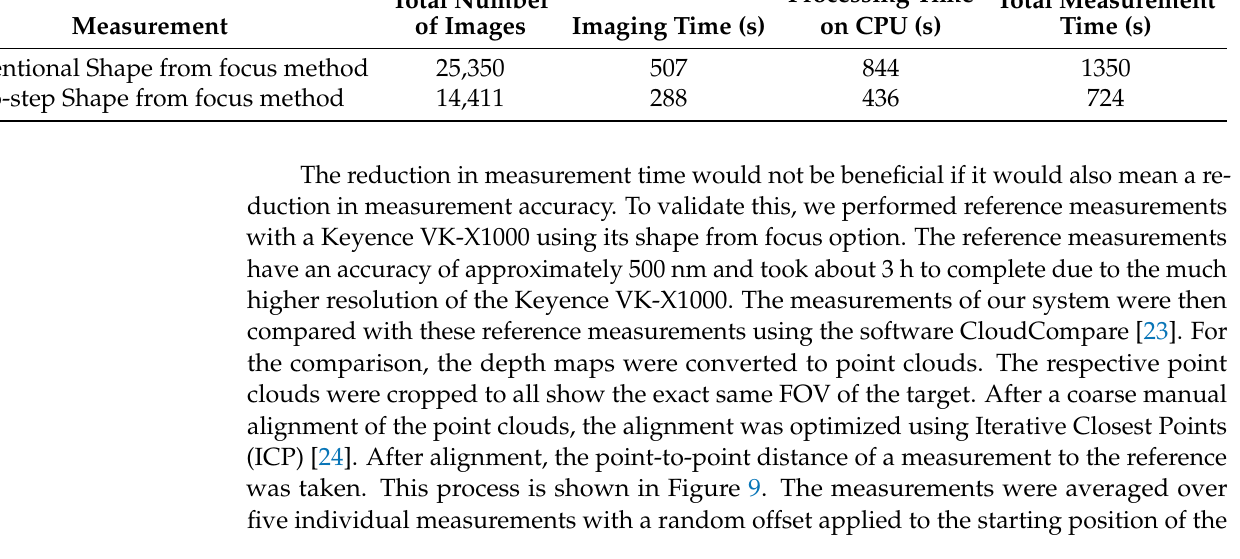
Table 1. Measurement and processing times for Conventional SFF and the proposed two-step SFF method. The processing method used was GLVM, implemented in Matlab R2019b [20] and run on a AMD Ryzen 3900 × CPU.